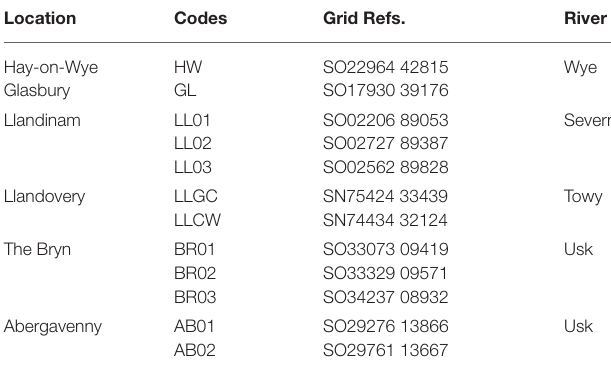
TABLE 1 | Location of 12 sites surveyed in 2017.